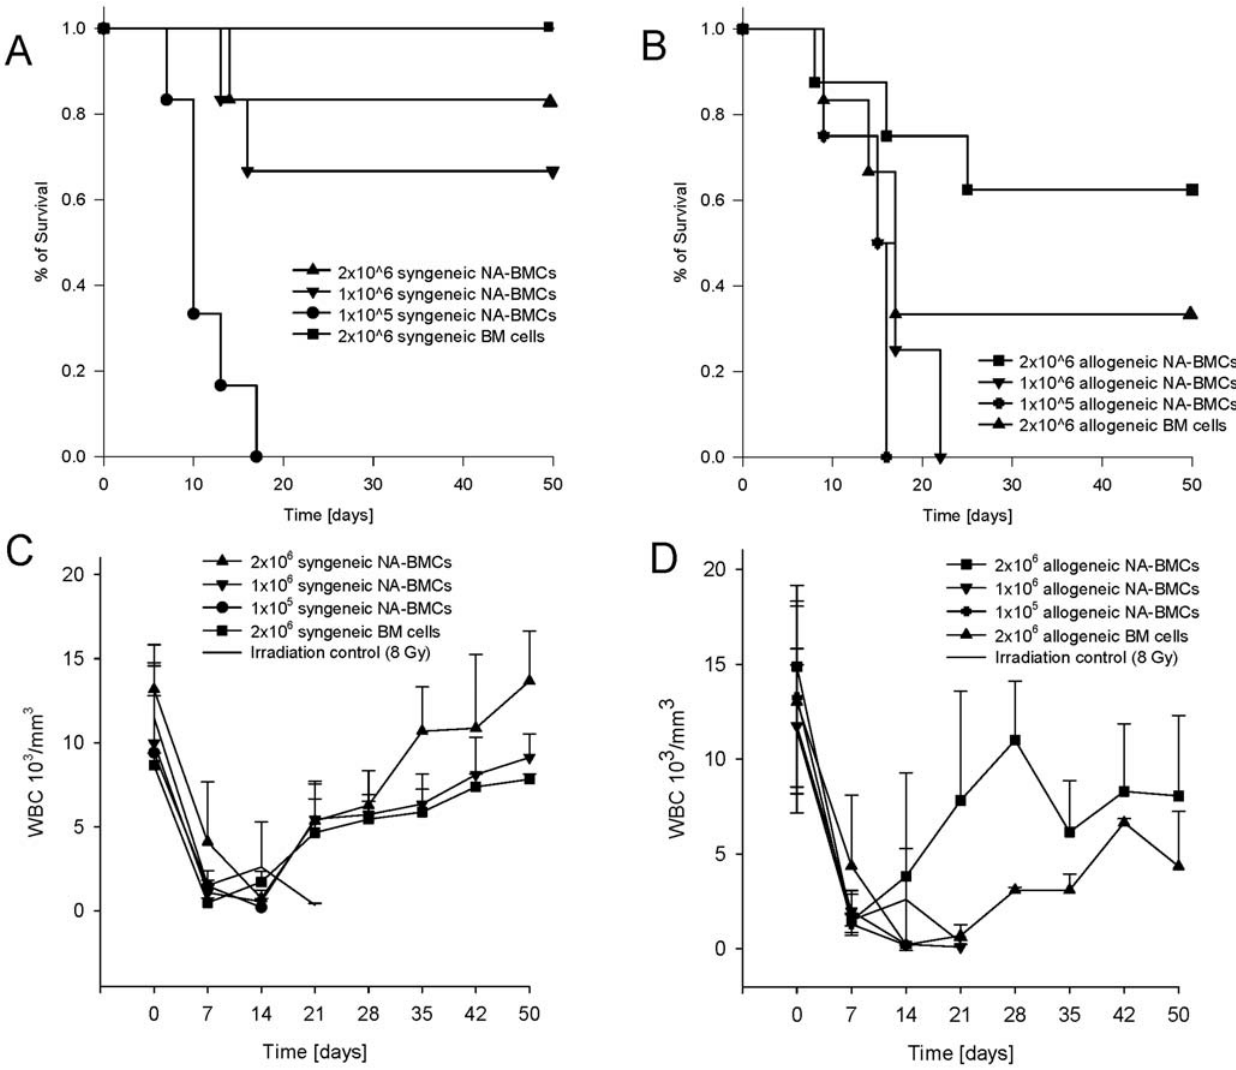
Figure 2. Survival analysis (A + B) and recovery of white blood cell count (WBC, C + D) after irradiation and transplantation. Transgenic mice (C57Bl/6) received either syngeneic or allogeneic NA-BMCs (1 6 10 5 to 2 6 10 6 cells) or syngeneic and allogeneic bone marrow (2 6 10 6 cells). Recovery of WBC after lethal irradiation and transplantation of 2 6 10 6 syngeneic NA-BMCs or 2 6 10 6 syngeneic bone marrow cells (C) and 2 6 10 6 of allogeneic NA-BMCs compared to transplantation of 2 6 10 6 allogeneic bone marrow cells (D).